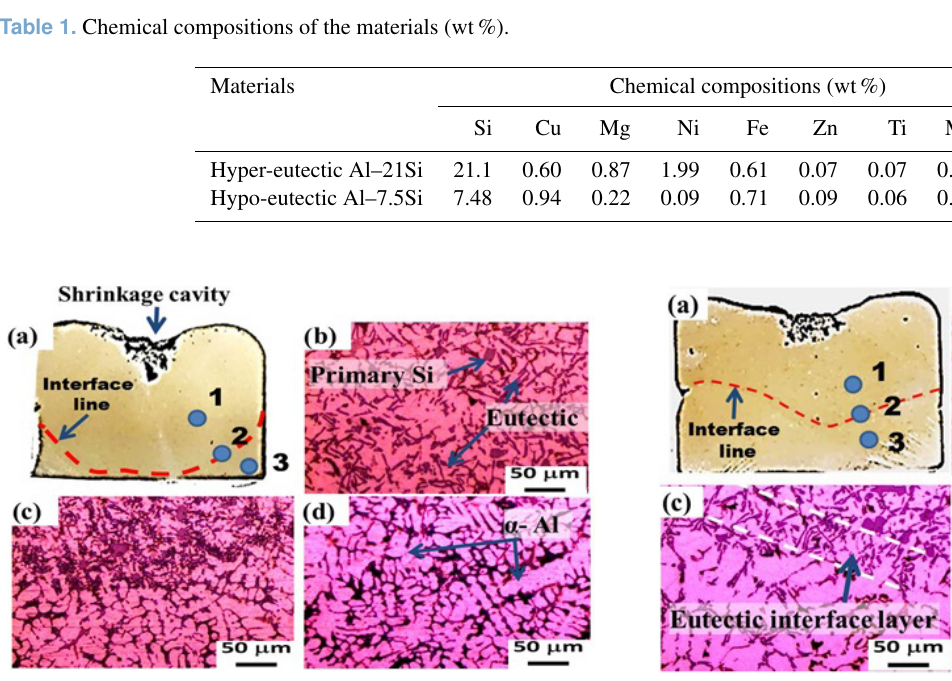
(point 2) and on the zone above the interface (point 1) (see Fig. 2b,